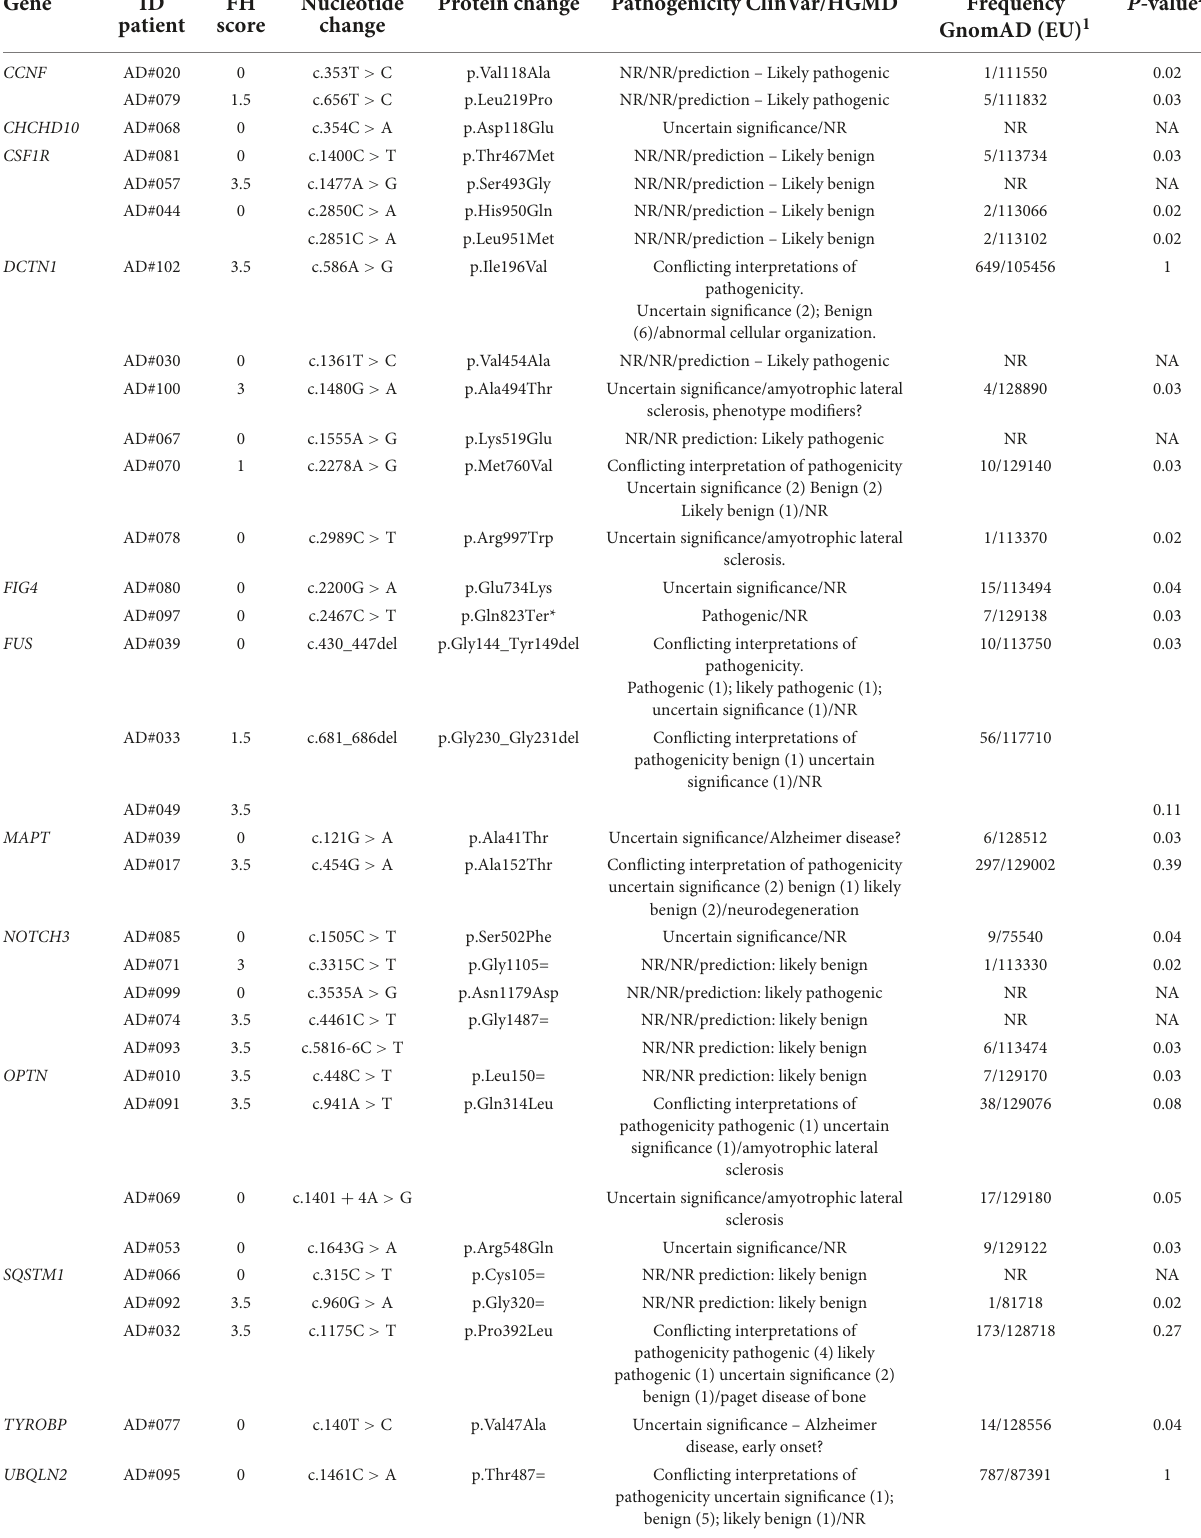
TABLE 4 Rare variants in other dementia causative genes identified in this